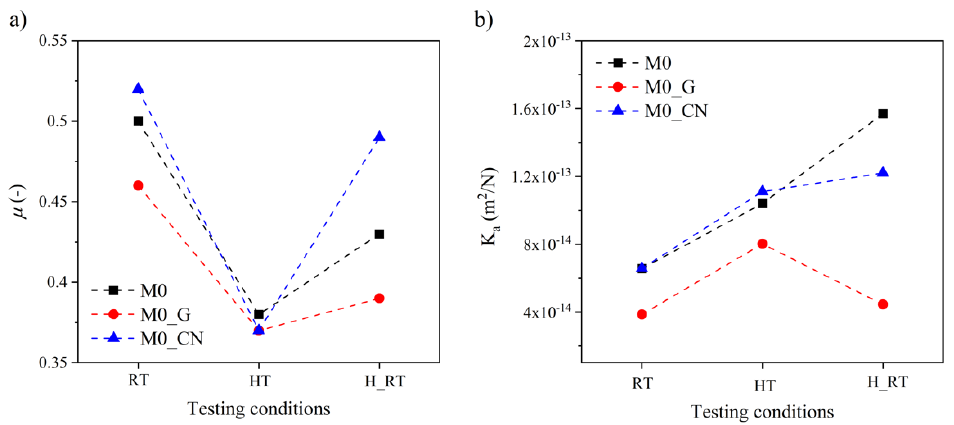
Figure 9. Comparison of ( a ) µ values and ( b ) Ka values obtained during the tests at RT, HT and